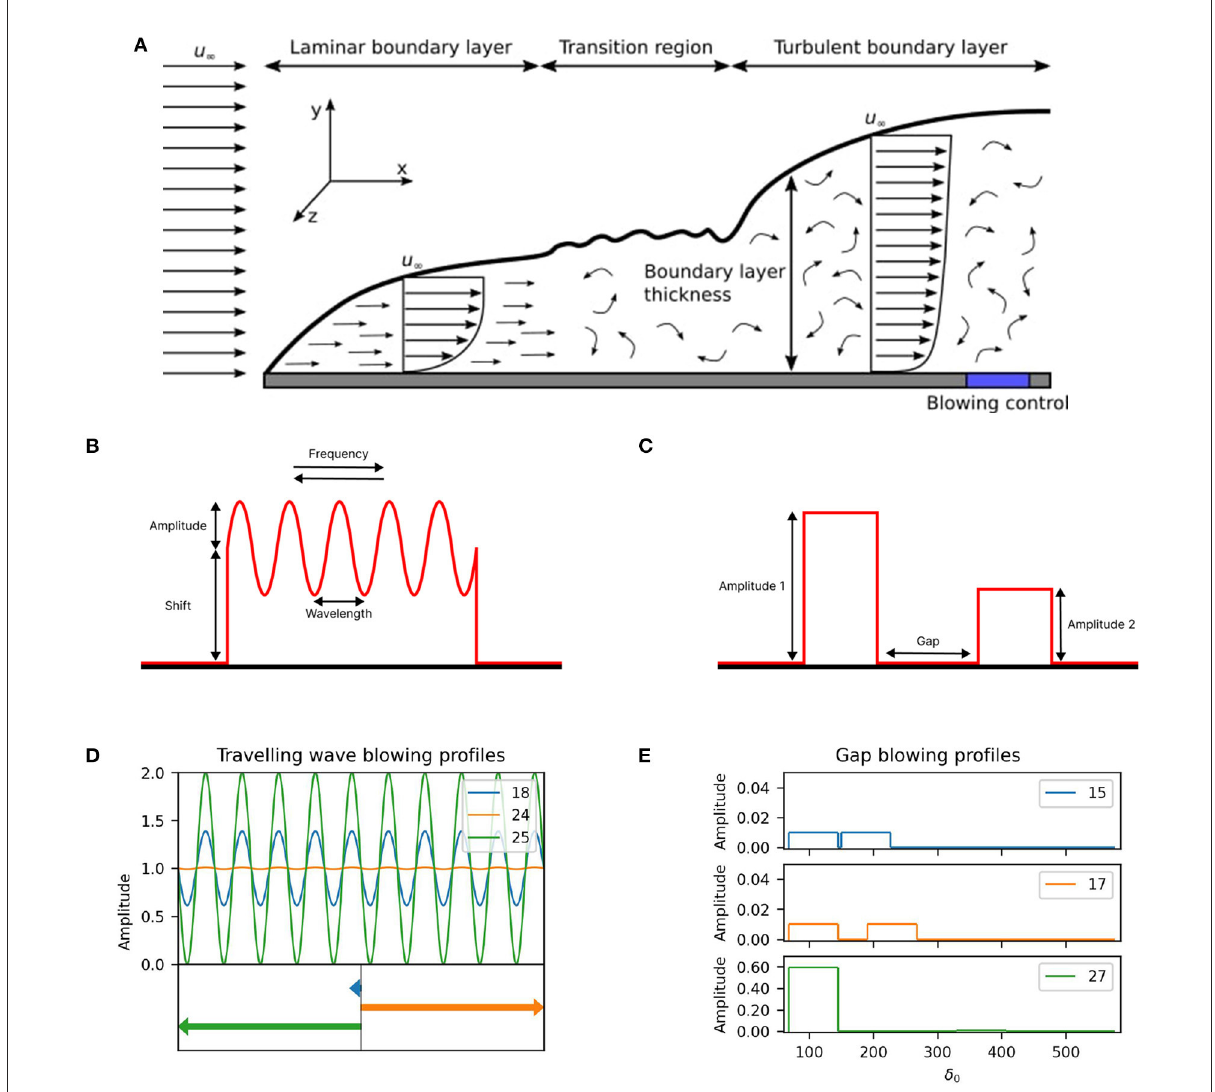
FIGURE7 CFD simulations. Panel (A) illustrates the flow over a flat plate. Initially the boundary layer is laminar. However, at a critical streamwise length from the leading edge, the flow transitions to a turbulent boundary layer, which is characterized by an increase in turbulent activity and skin-friction drag. The blue shaded region illustrates the location of the blowing control region in the present study; Panel (B) shows the traveling wave blowing profile specified by an amplitude, a wavelength, a traveling frequency and a shift parameter; Panel (C) shows the gap blowing profile specified by two blowing areas with individual amplitudes separated by a gap; Panel (D) shows the traveling wave blowing profiles for iterations 18, 24, and 25 where the arrows on the bottom of the plots illustrate the direction and strength of travel; Panel (E) shows the gap blowing profiles for iterations 15, 17, and